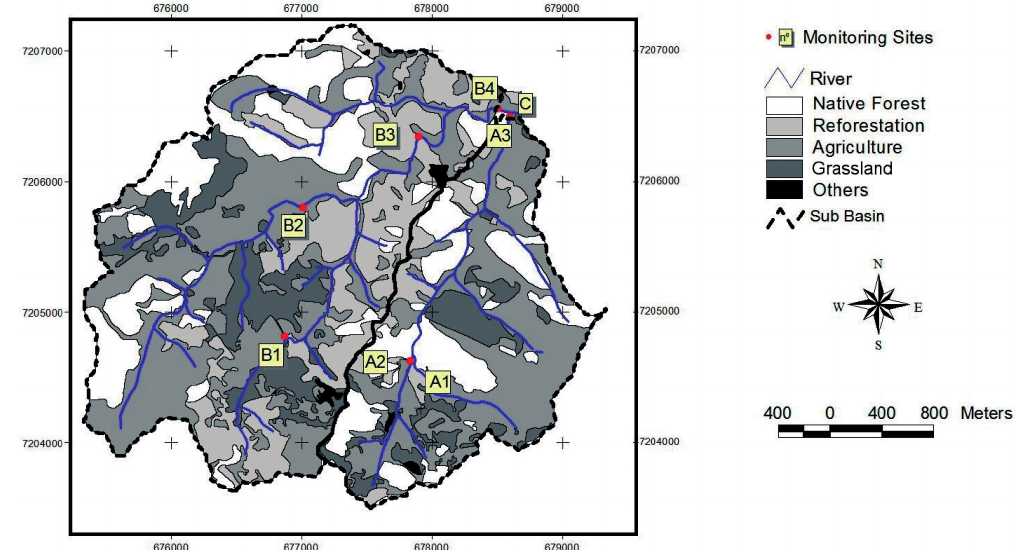
Figure 3. Land use and monitoring sites in the Campestre